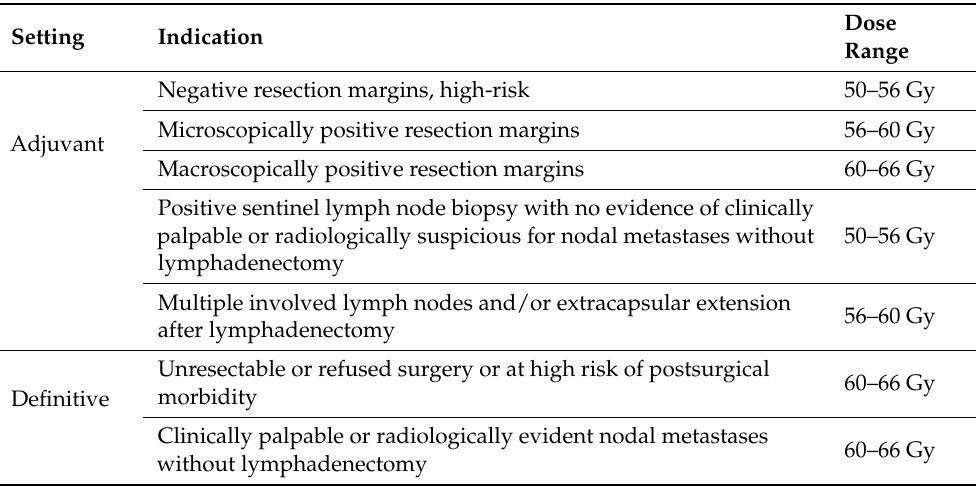
Table 1. Total doses in 2 Gy fractions recommended by National Comprehensive Cancer Network Guidelines in various clinical